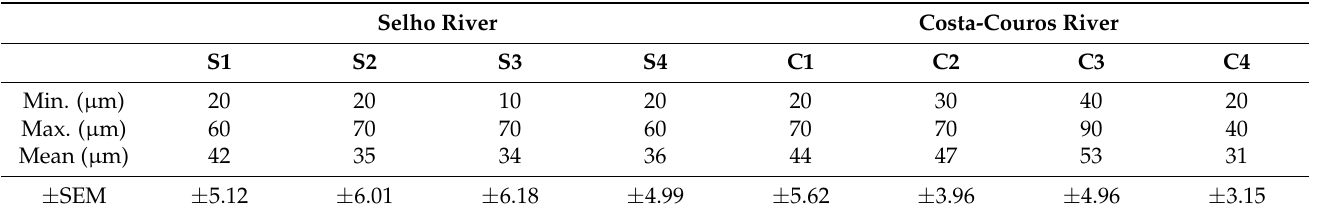
Figure 3. Random photos of a 100 mm 2 area of a glass fiber membranes (in a total of approximately 1734.94 mm 2 , i.e., total area of the filter) containing MPs extracted from the Oligochaeta’s gut ( A ) and the sediment ( B ) of Costa-Couros river sampling sites. MP particles presented a red fluorescence according to Prata et al. [47]. Circles symbolize which particles were counted as MPs, while crosses symbolize those not counted as MP particles. Table 4. Minimum, maximum, and mean ± SEM sizes of random samples of ten MPs existing in the digestive tract of Oligochaeta collected from four sampling sites of Selho (S1 to S4) and Costa-Couros (C1 to C4) rivers.